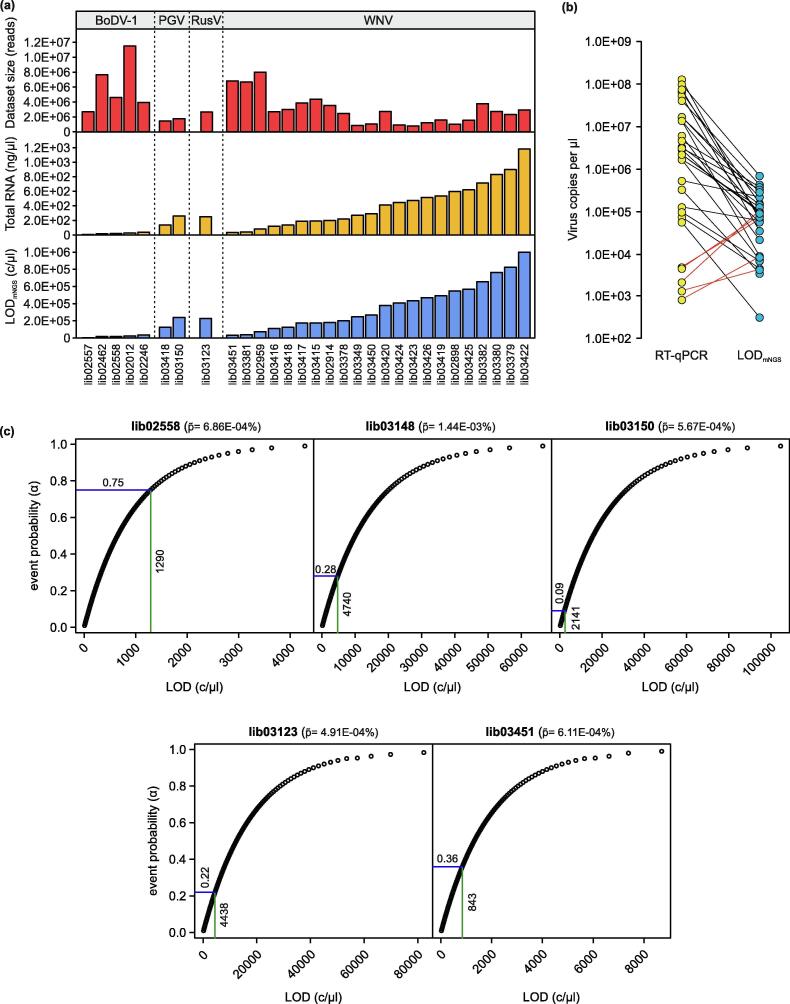
Calculation of the sample-based detection limit from datasets. (a) Key characteristics of the analysed samples and datasets. Upper panel, dataset size; mid panel, total RNA concentration; lower panel, LODmNGS. Calculations were performed with 30 datasets originated from diseased animals (Table 1) by combination of equations 2, 3, and 4. (b) Comparison of the LODmNGS (c/µl) and viral genome copy numbers (c/µl) as determined by RT-qPCR quantification of the samples. Red lines display the samples where LODmNGS > RT-qPCR c/µl. (c) Probability-based calculation of LODmNGS for the five samples labelled red in (b). Horizontal lines represent the adjusted α to meet the criteria LODmNGS < copy number determined by RT-qPCR. Vertical lines represent the calculated LODmNGS (c/µl) with the adjusted α. (For interpretation of the references to colour in this figure legend, the reader is referred to the web version of this article.)